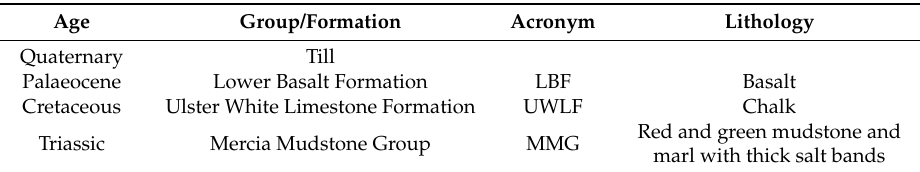
Table 4. Reference summary geology for the Ligoniel Park area.